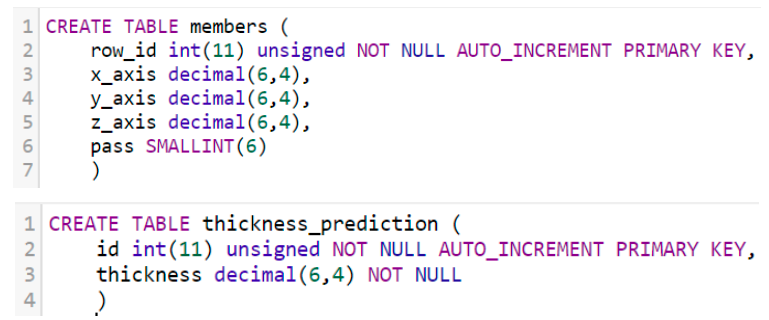
Figure 13. Table creation on MySQL.